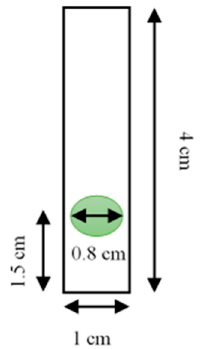
Figure 1. The optical pH sensor plate.